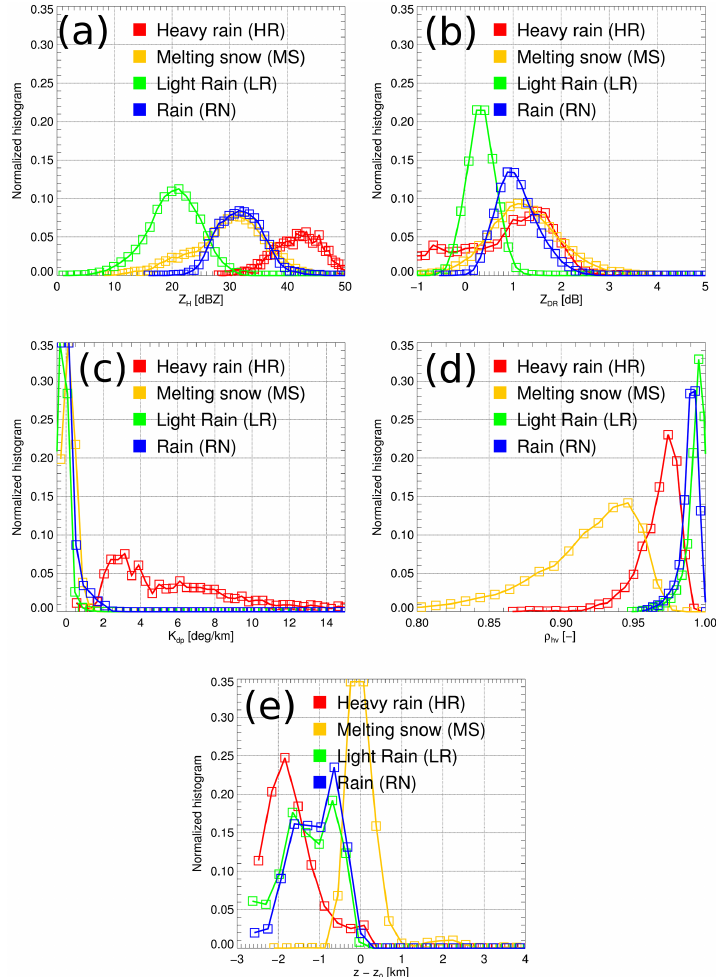
Figure 5. Distribution within the four clusters found at positive temperatures ( (cid:49)z ≤ 0) of (a) Z H [dBZ], (b) Z DR [dB], (c) K dp [ ◦ km − 1 ], (d) ρ hv [–], and (e) (cid:49)z [km]. The curves are obtained considering the content of 100 runs of the clustering